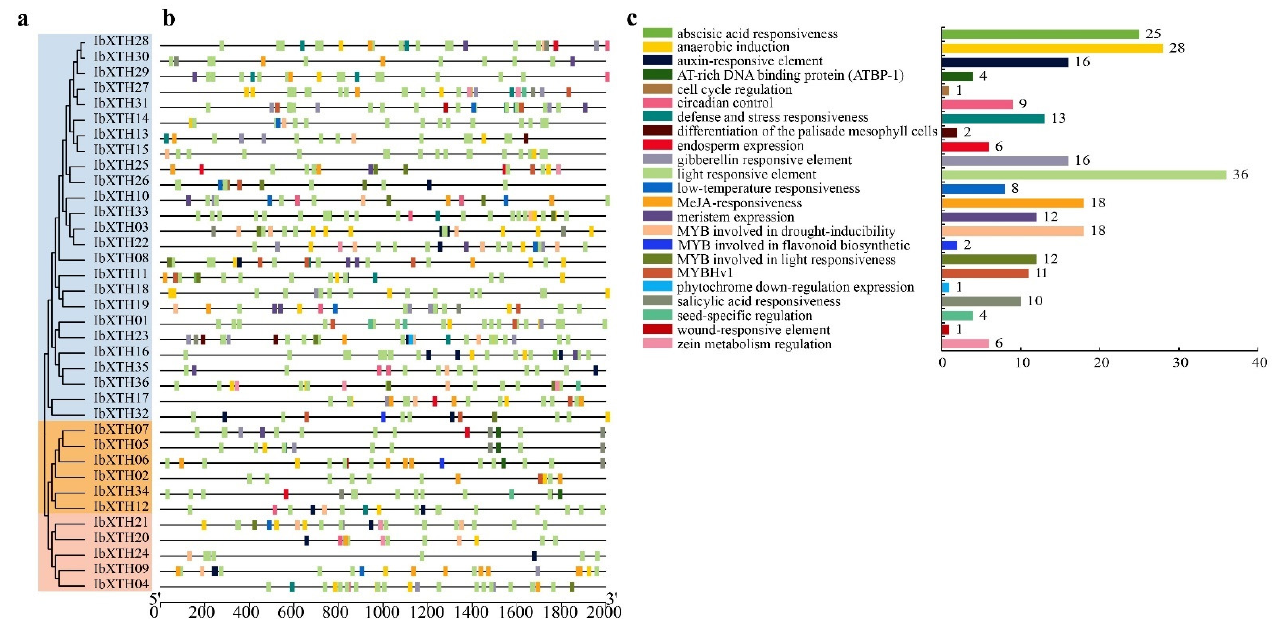
Figure 7. Cis-elements predication in the 2 kb sequences upstream of the sweet potato XTH gene promoters. ( a ) The phylogenetic tree of the sweet potato XTH genes clustered by MEGA7.0 Genes from groups III A and IIIB are shown in the orange and pink color, respectively. Subfamily I / II is shown in blue. ( b ) Cis-acting element distribution, each box filled with a different color represents different promoters. ( c ) Cis-acting element gene numbers.